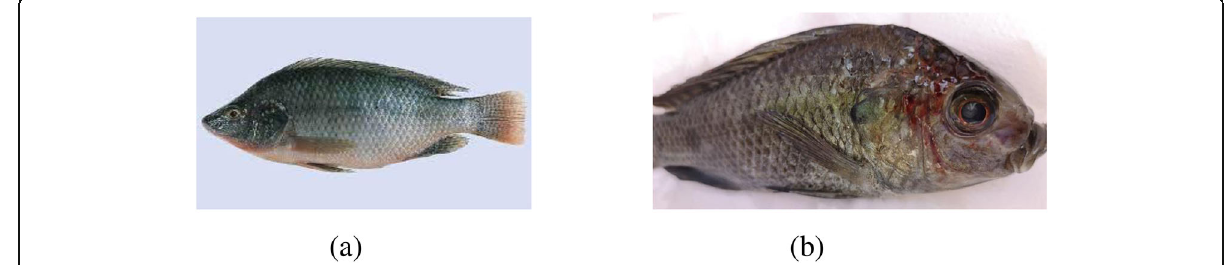
Fig. 4 a Control tilapia. b The effect of Copper nanoparticles and dibutyltin on tilapia